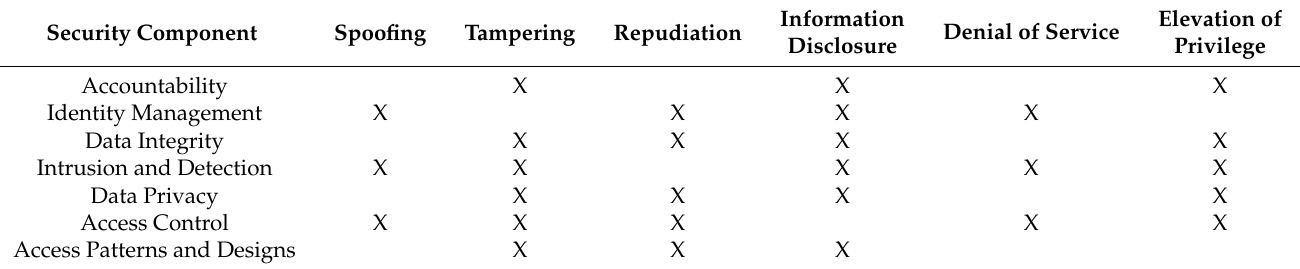
Table 10. Cloud computing security and privacy component using